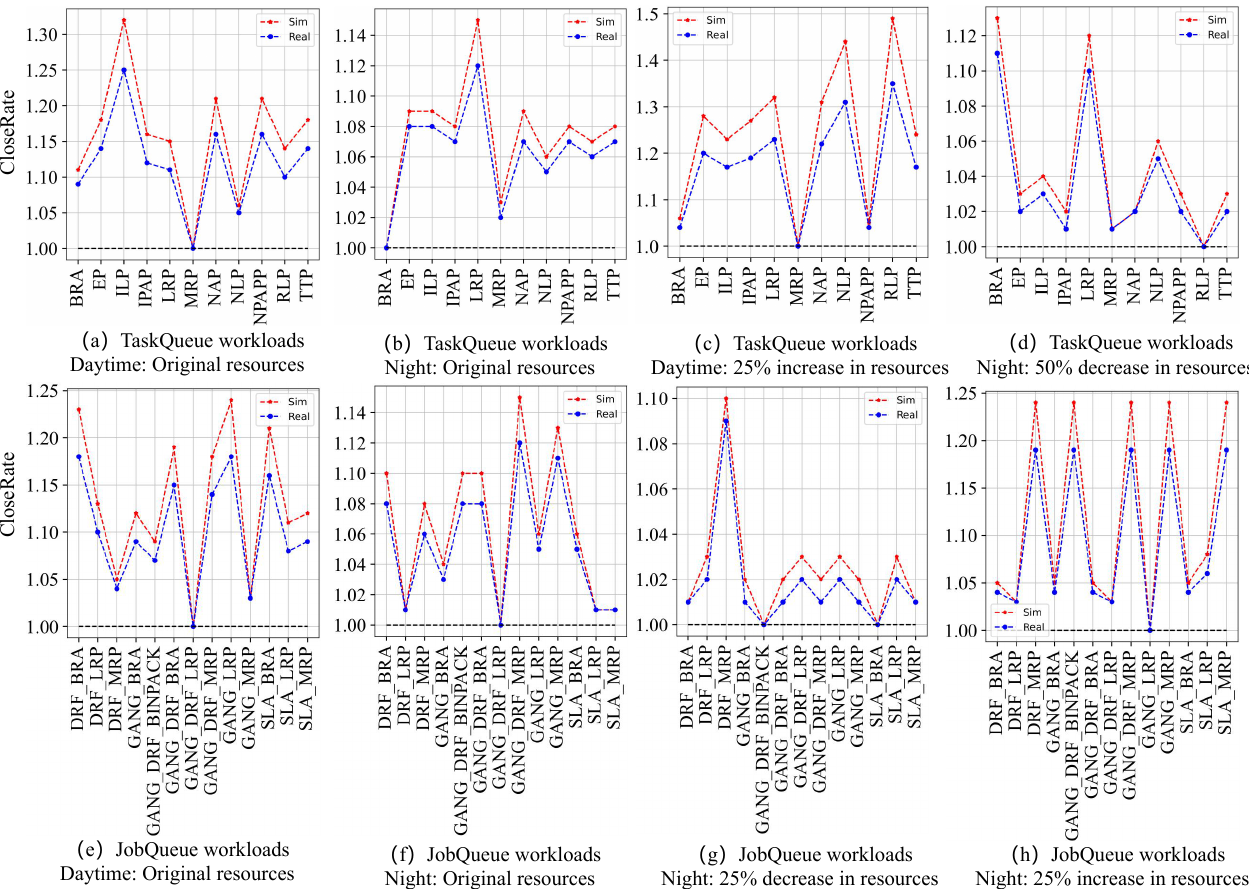
Figure 12. Comparison of CloseRate in simulation and real cluster environments under different workloads and changeable available